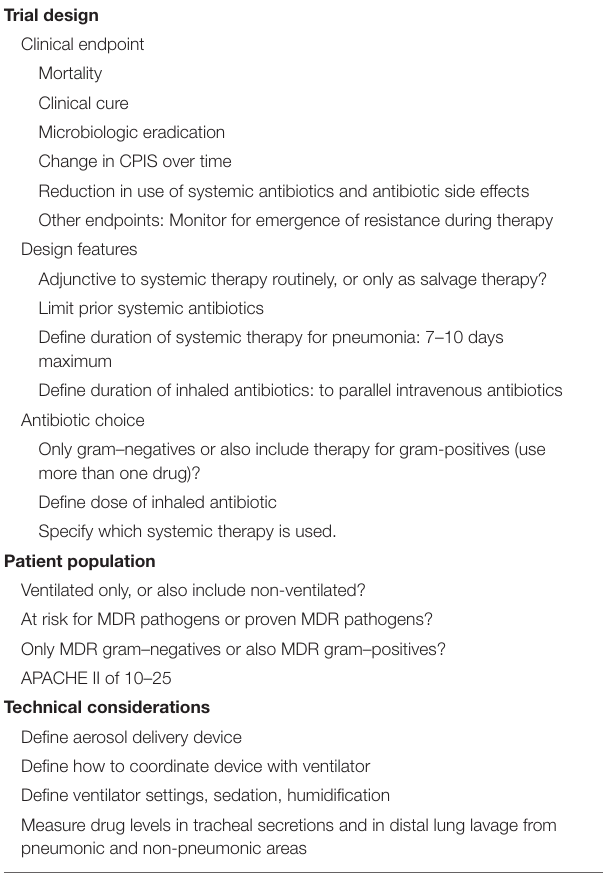
TABLE 3 | Features to consider in the design of future trials of inhaled